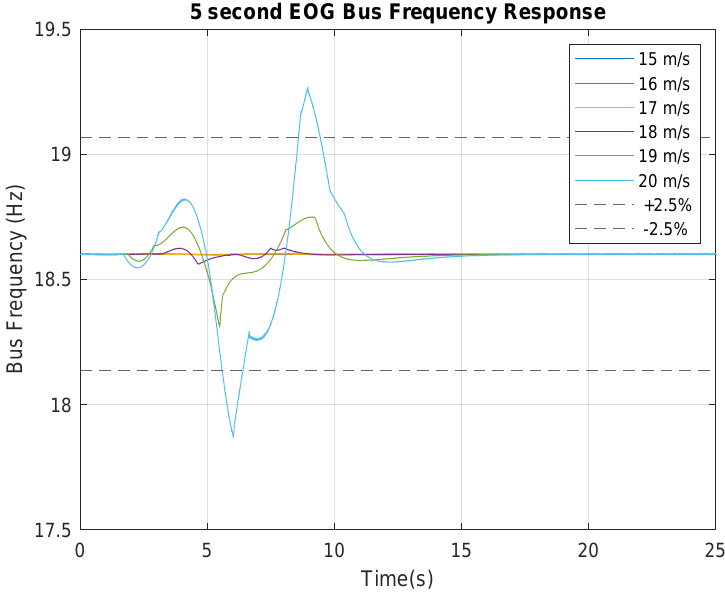
Figure 15. EOG Bus Frequency Responses ∆ T = 5 s.